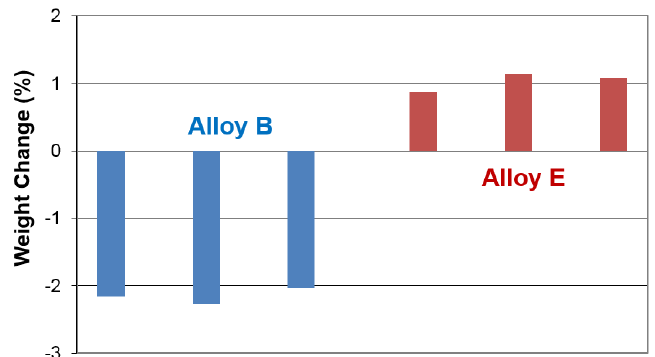
Figure 9. Weight changes after KOH-etching for three electrodes from B (left) and three from E (right). Table 3. Measurement of weight change before and after KOH-etch for A and B . All numbers are in mg.